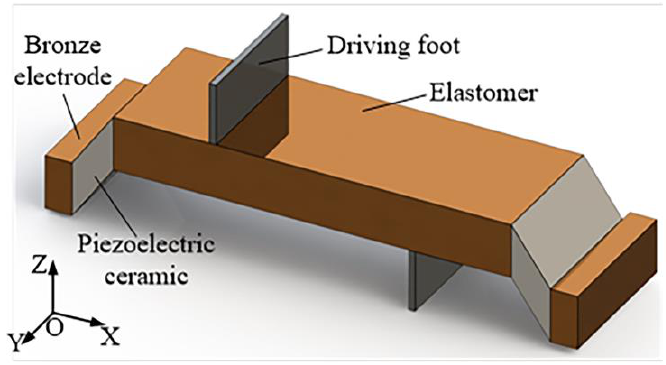
Figure 1. The structure of motors: the motor works on L1B2 coupling.